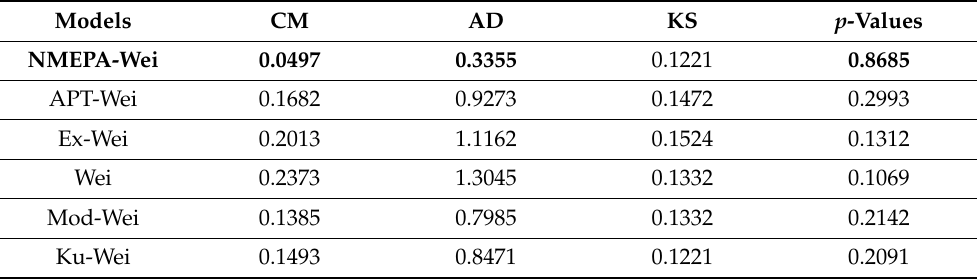
Table 4. The goodness of fit CM, AD, and KS measures, and p -value of the competitive models for glass fiber data set (Data